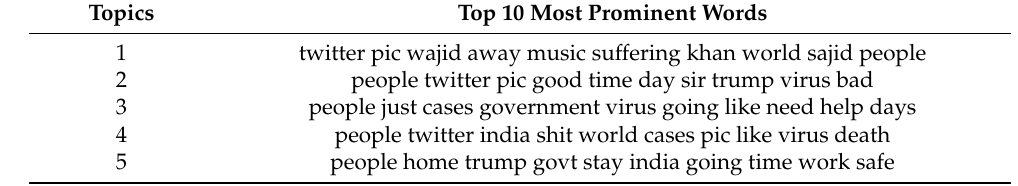
Figure 9. Top 10 most frequent words for the first dataset.